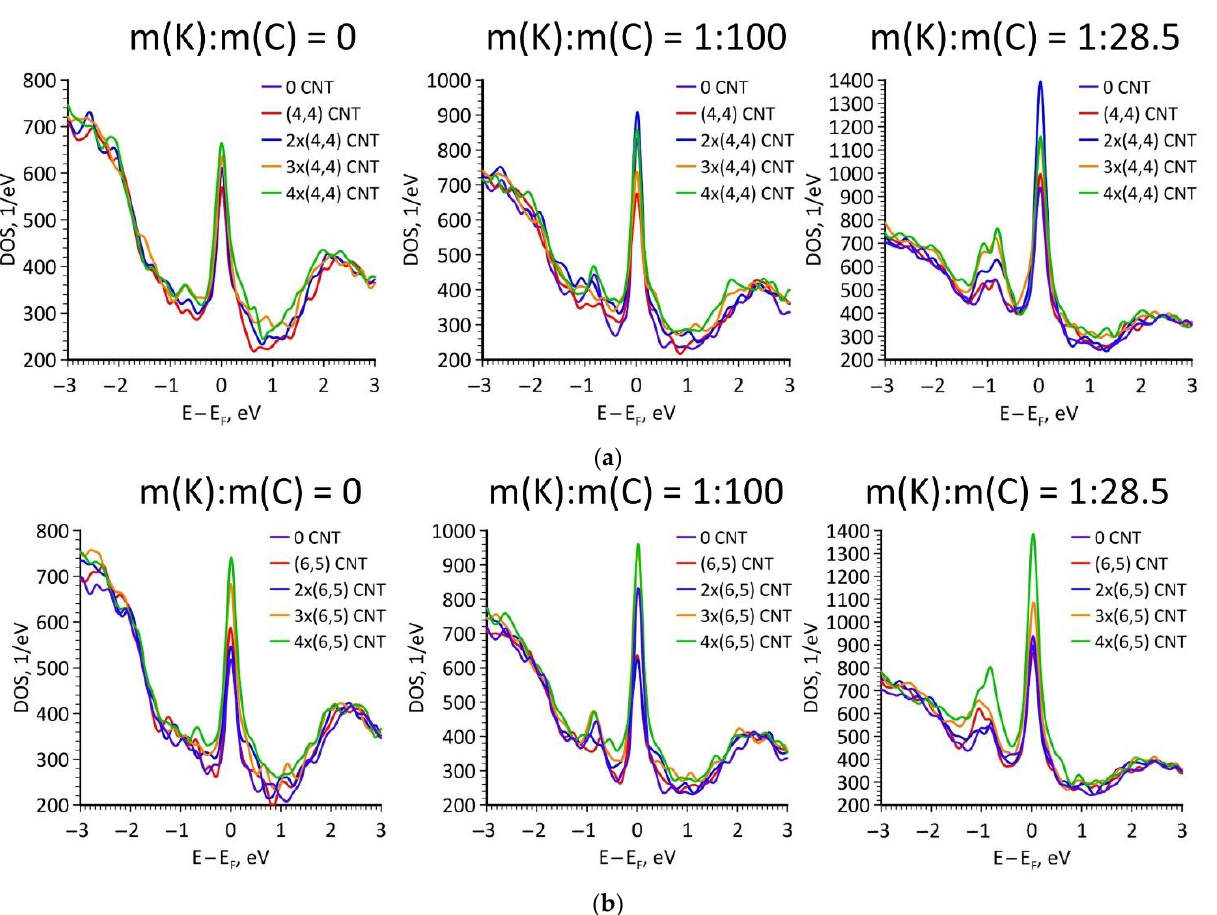
Figure 4. DOS of GLC reinforced with (4,4) SWCNTs ( a ) at potassium content 0, 1:100, and 1:28.5, and with (6,5) SWCNTs ( b ) at potassium content 0, 1:100, and 1:28.5.